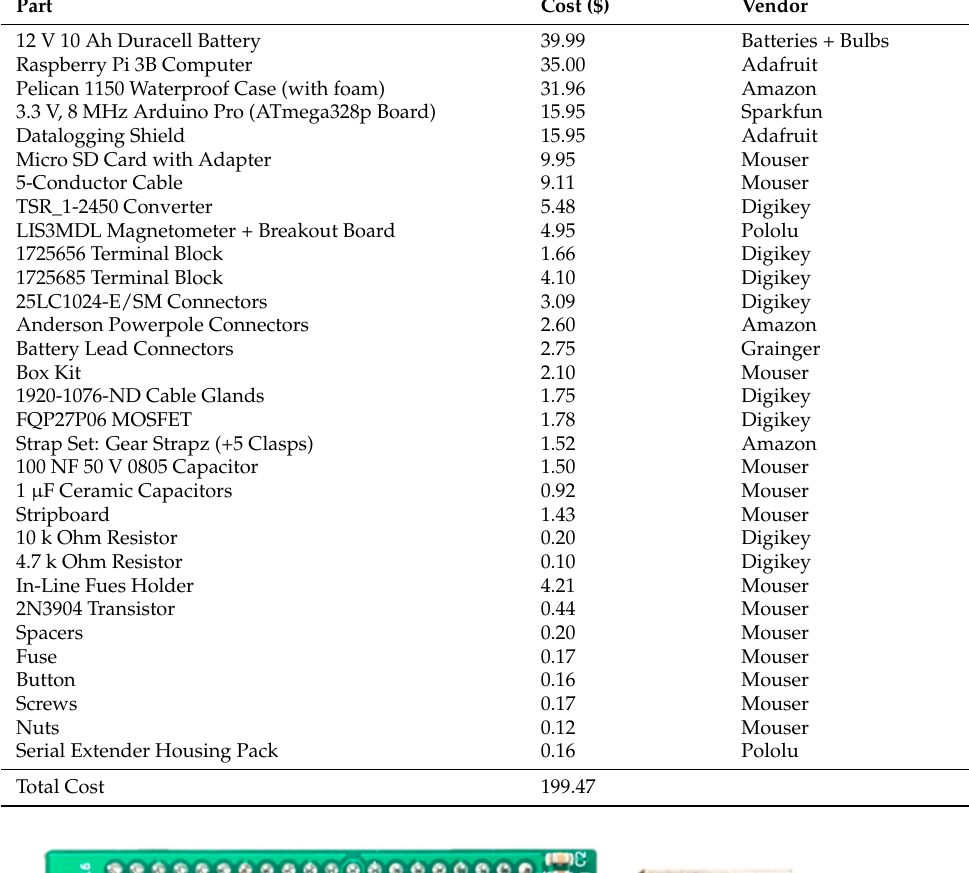
Table 2. Parts required and cost to build a CIWS computational node using off-the-shelf components.